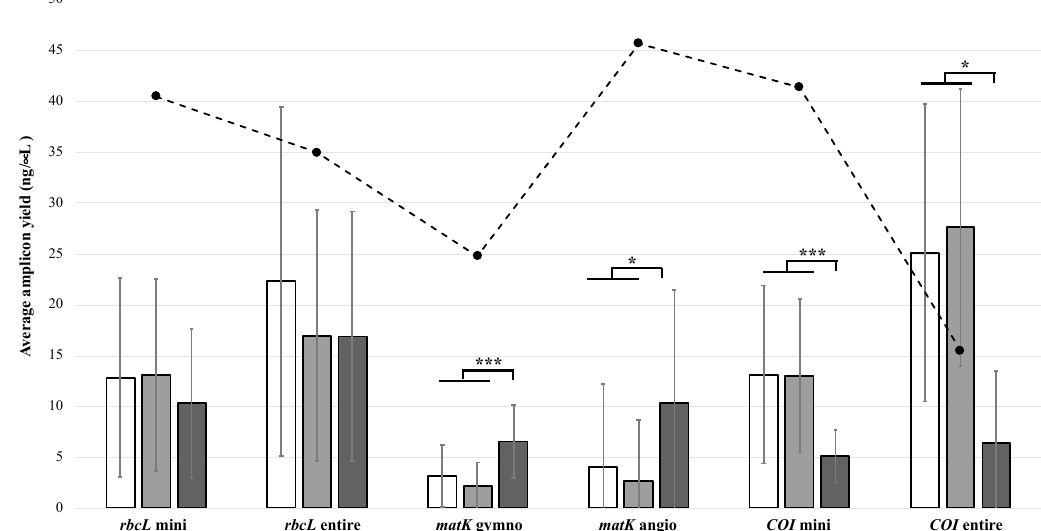
Figure 2. Amplification success of DNA barcode regions using six different primer pairs. Average (± standard deviation) amplicon yield (ng/ μ L) across all samples prepared using 250 mg of bulk soil ( n = 20; denoted by white bars), 100 mg of bulk soil ( n = 20; denoted by light grey bars) and individual fragments ( n = 10; denoted by dark grey bars). Significant differences in yield (as determined by t -test) are shown, with * denoting p < 0.05 and *** denoting p < 0.001. The dashed line represents the yield of the positive control.